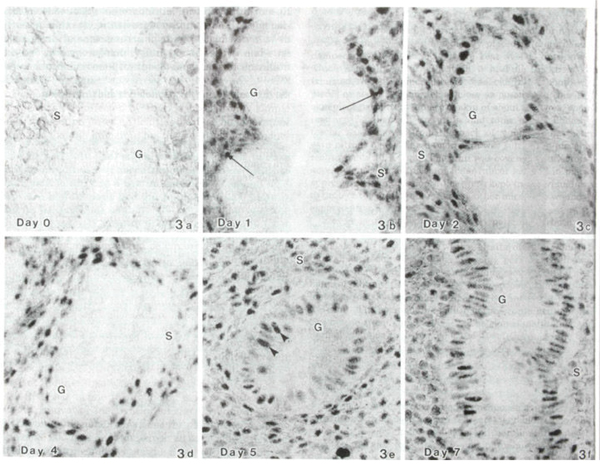
Demonstration that immunoreactive estrogen receptor was dramatically reduced by progesterone treatment in the rhesus monkey endometrium [37]. The top left panel shows the absence of estrogen receptor staining in the endometrial functionalis after estrogen plus progesterone. The other panels monitor the return of estrogen receptor immunoreactivity during progesterone withdrawal (days 1–7).